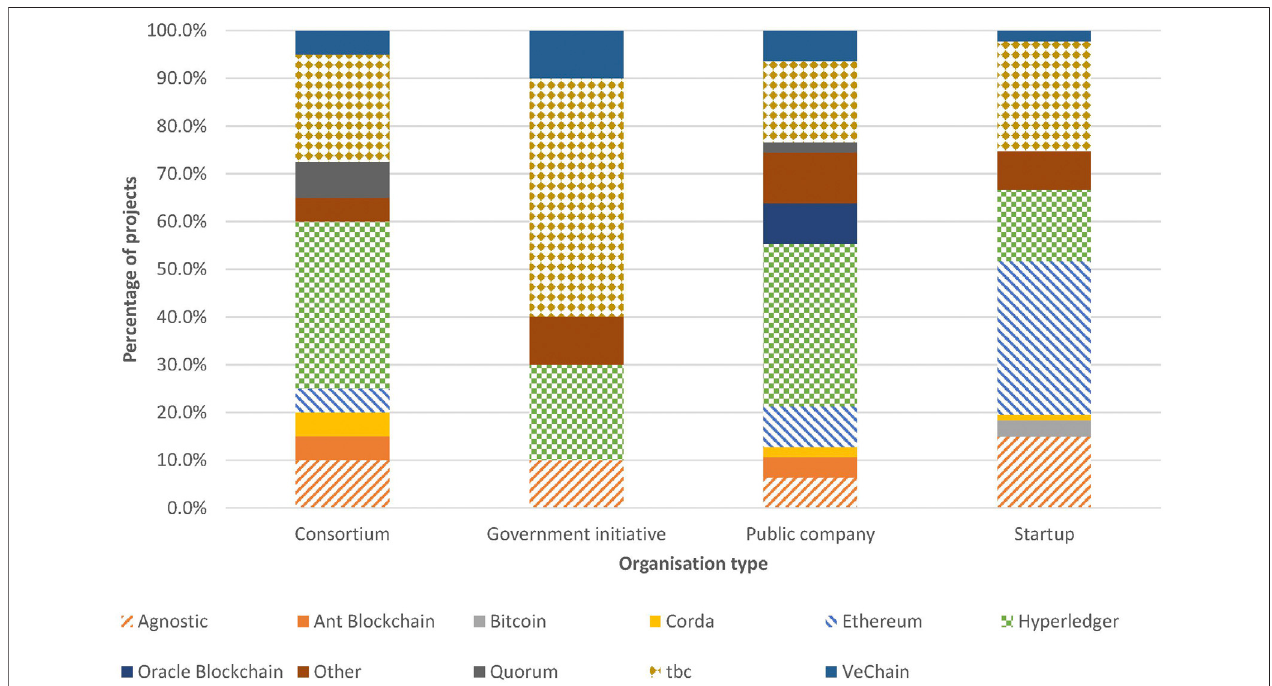
FIGURE 7 | The percentage of projects using a particular blockchain based on the type of organization leading the project.